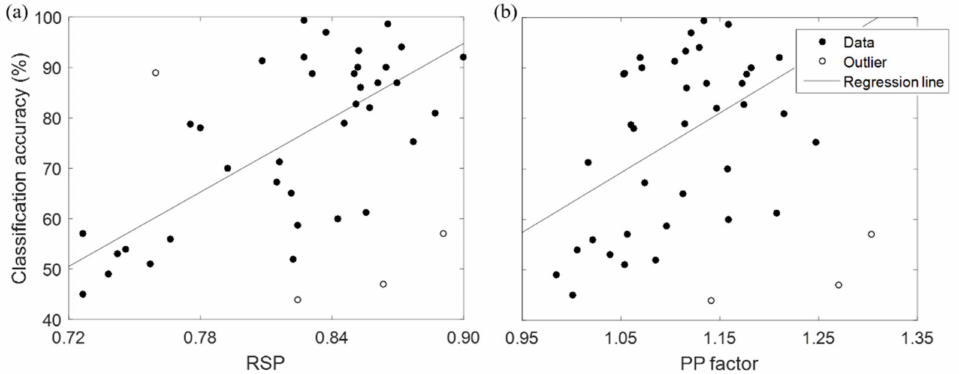
Figure 4. ( a ) Regression analysis between our proposed resting state predictor (RSP) and online BCI classification accuracy, ( b ) Regression analysis between the PP factor (Ahn et al. [23]) and online BCI classification accuracy. Outliers (at the 90% confidence interval) are shown as blank